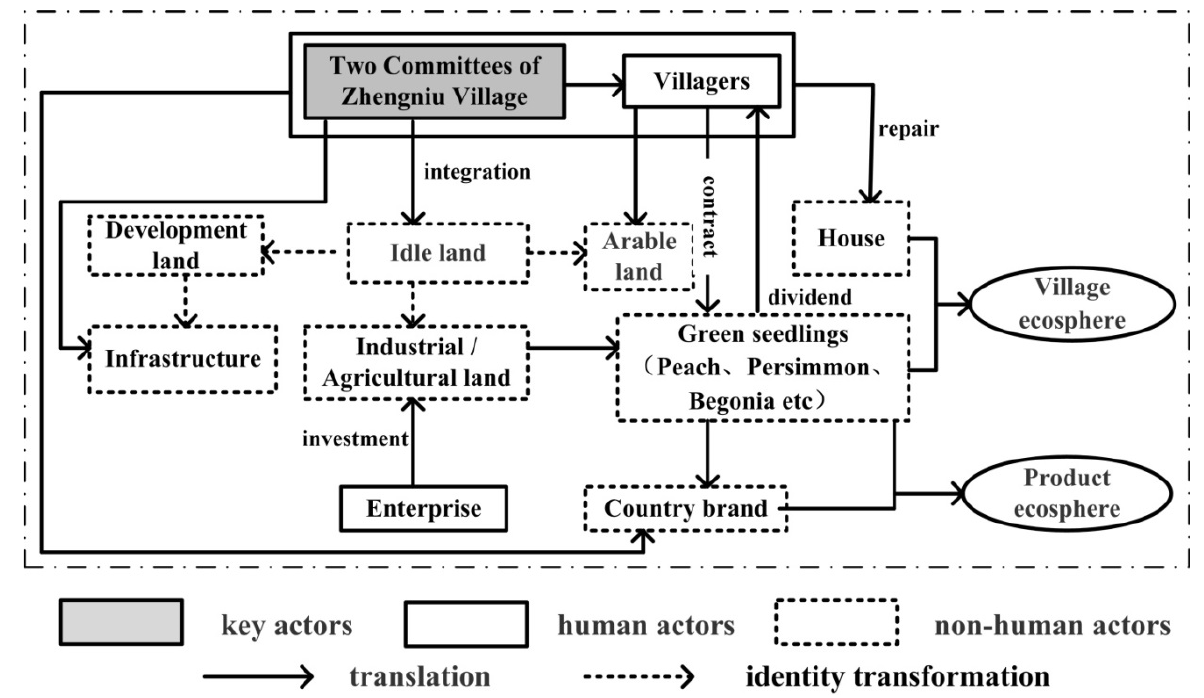
Figure 8. Action network of village intensive–idle land revitalization mode.